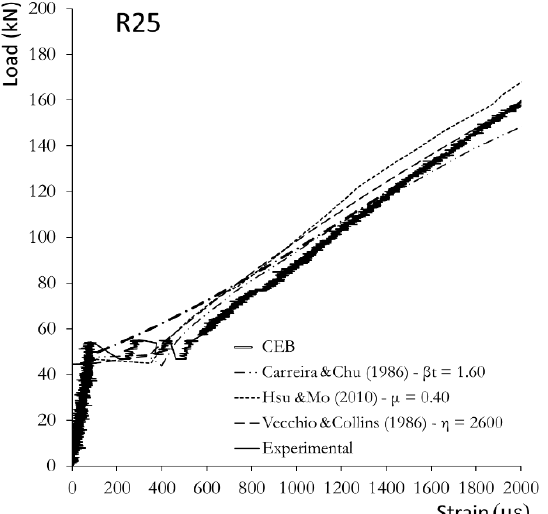
Figure 12. Comparison between numerical models, analytical model and experimental result for the tension stiffening element with recycled concrete R25.